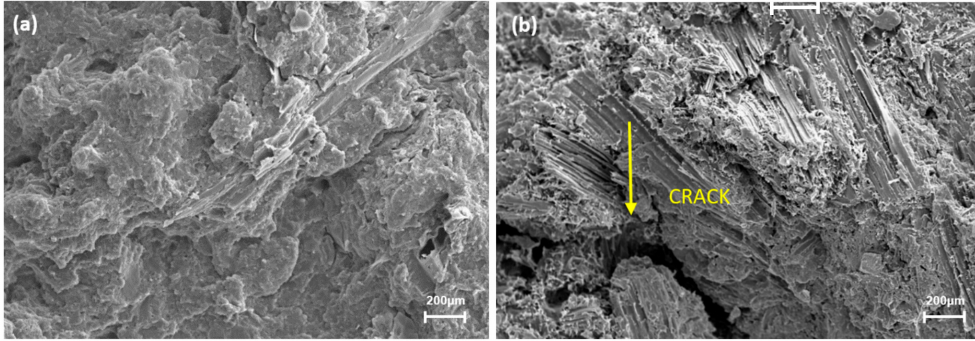
Figure 6. The morphology properties of the flexural fracture surface of: ( a ) PP/NCC-UB; and ( b ) PP/NCC-B.